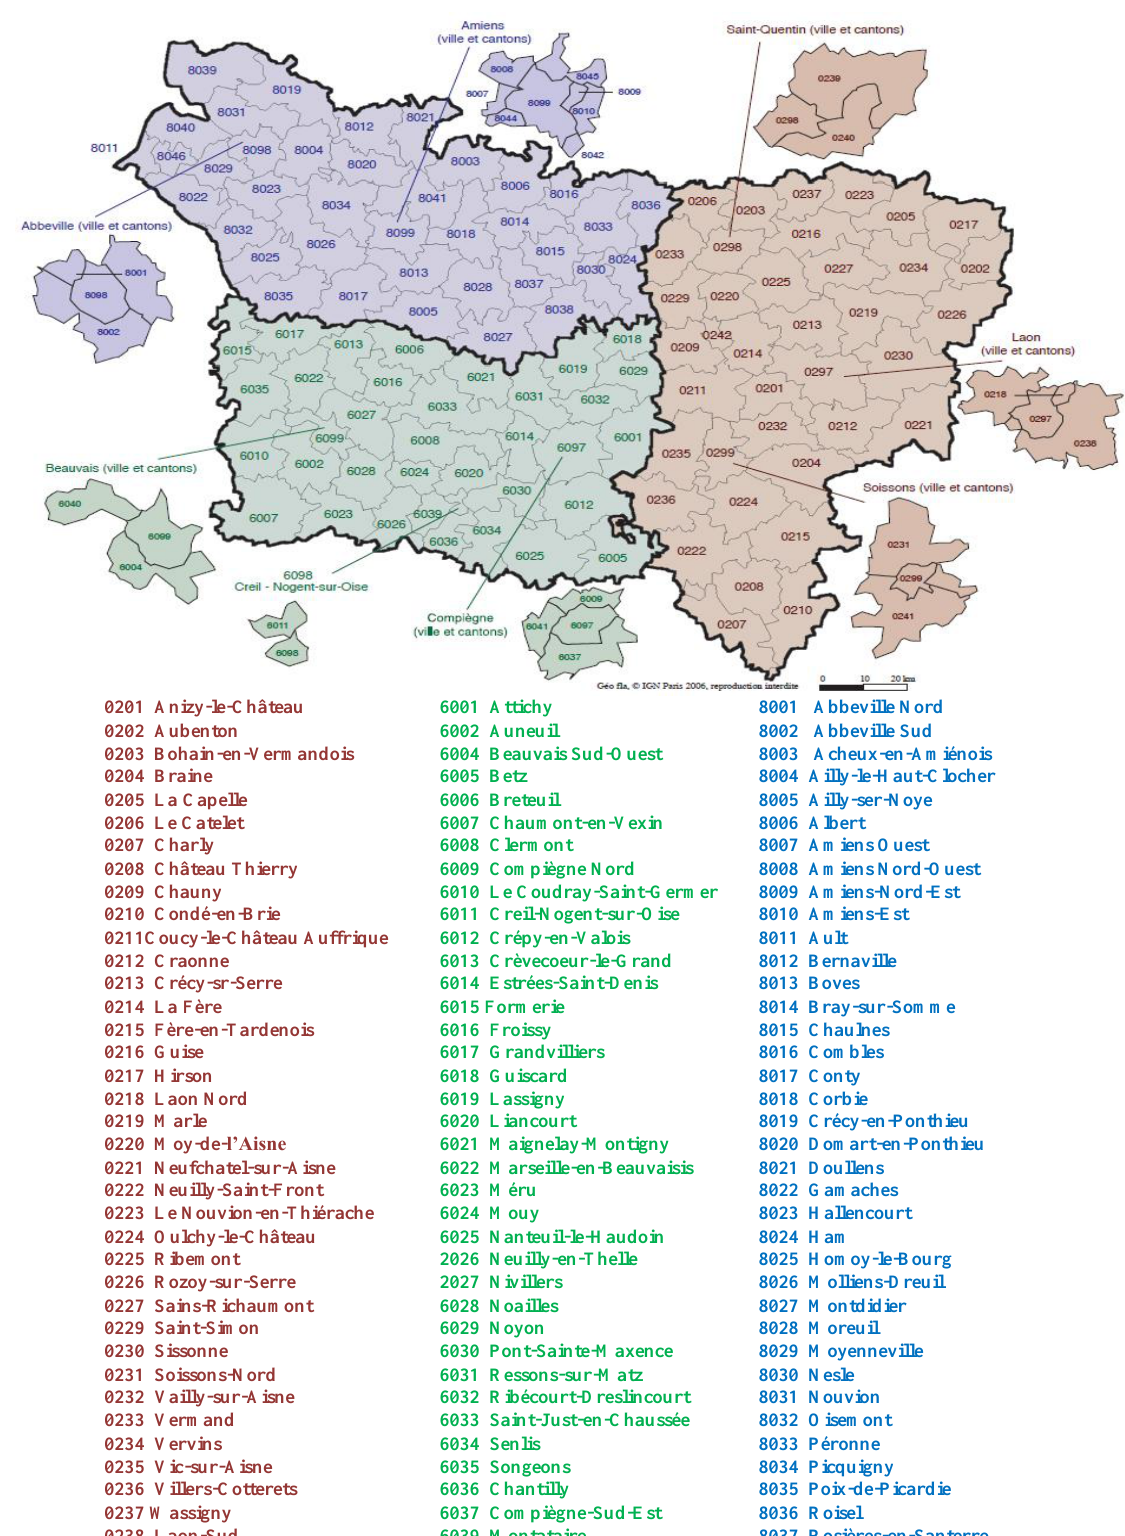
Figure 1 . Map of the study